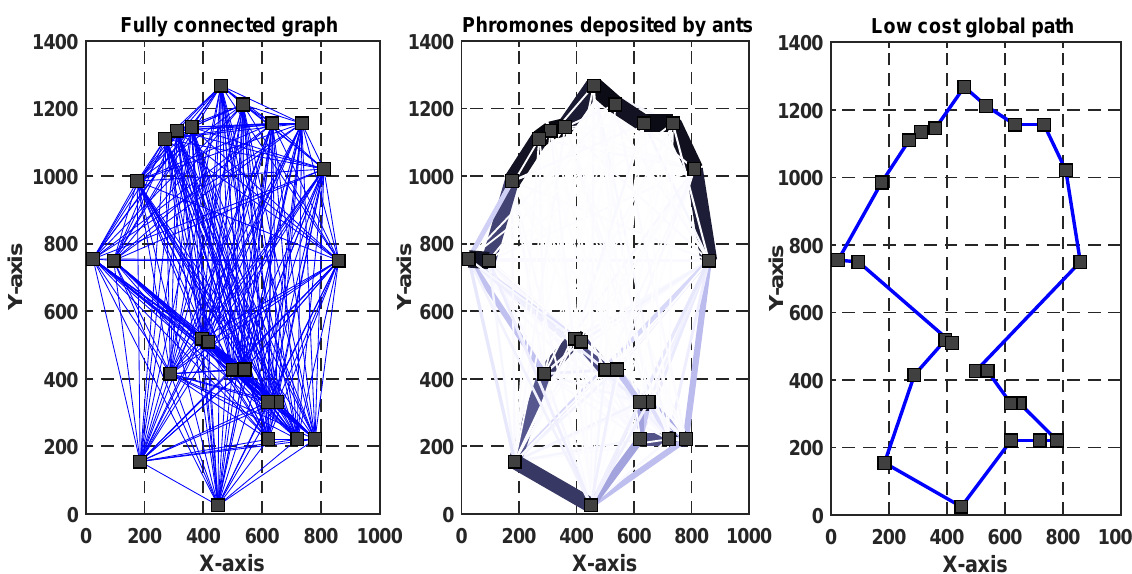
Figure 8. Determining the visiting sequence as a closed tour of the SFSs using the ACO algorithm.